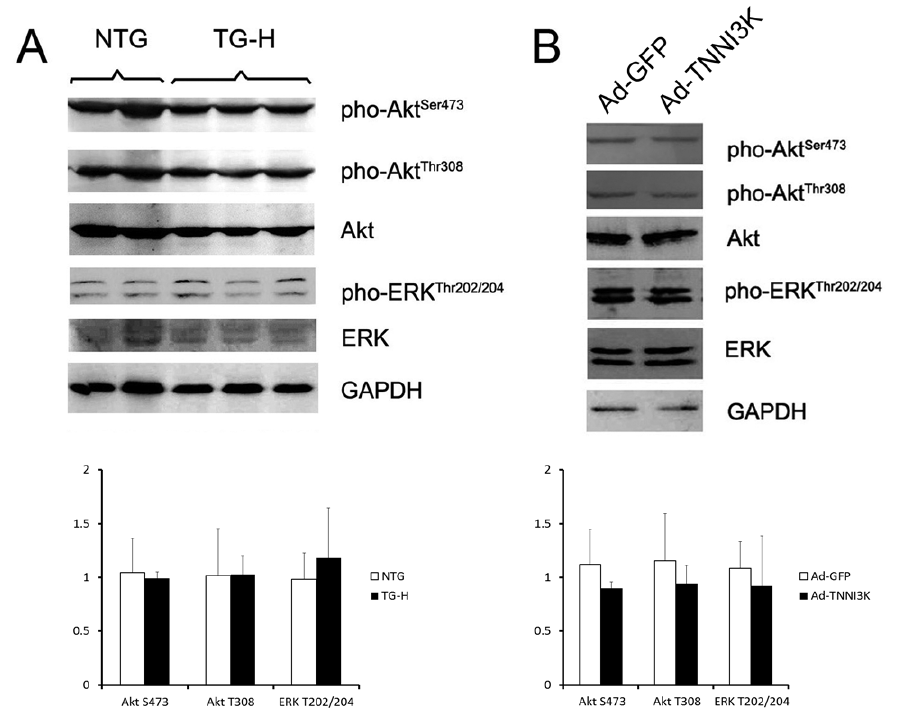
Figure 5. TNNI3K did not induce activation of Akt and ERK invivo and invitro . A: Western blot assessment for phosphorylation of Akt and ERK from transgenic hearts and nontransgenic control hearts at the age of 3 month. B: Cardiomyocytes were infected with Ad-TNNI3K and Ad-GFP for 48 hours and phosphorylation of Akt and ERK were analyzed by western blot. No significant phosphorylation increase was detected for the two effectors in vivo and in vitro . Each data point is shown as mean 6